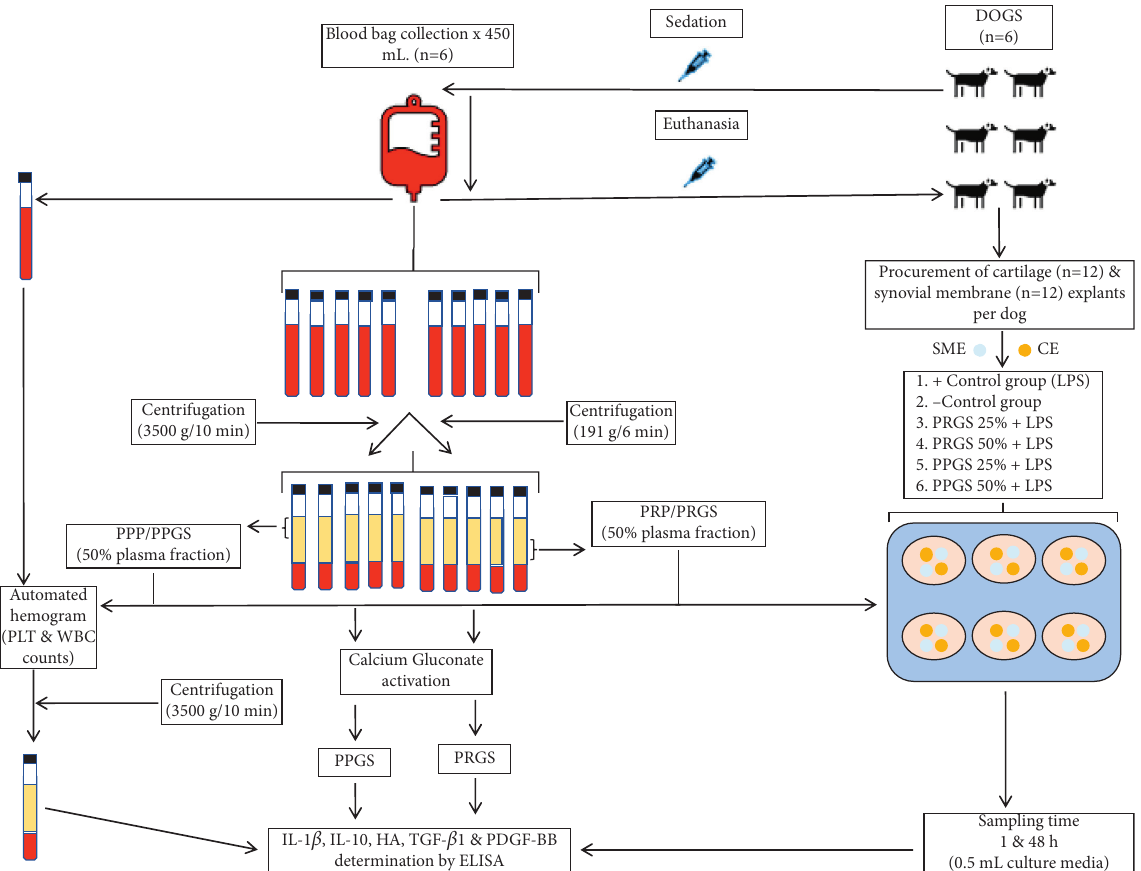
Figure 1: Study design and methodology. HA, hyaluronan; IL, interleukin; LPS, lipopolysaccharide; PLT, platelet; PDGF-BB, platelet- derived growth factor isoform BB; PPP/PPGS, platelet-poor plasma/platelet-poor gel supernatant; PRP/PRGS, platelet-rich plasma/platelet- rich gel supernatant; TGF- β 1 , transforming growth factor beta 1; WBC, white blood